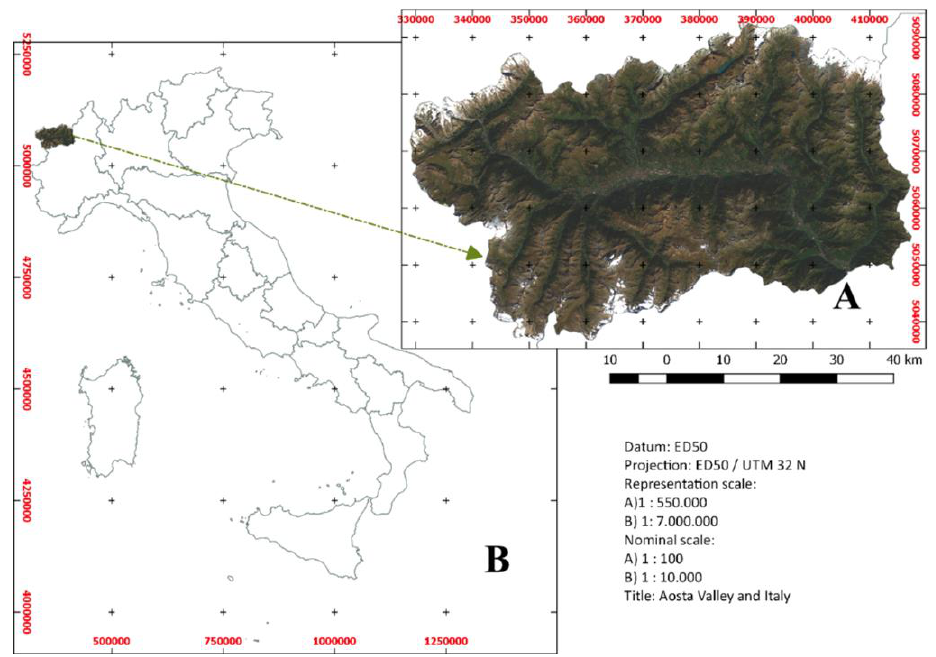
Figure 2. The study area corresponds to the entire Aosta Valley that is located in the Northern West Alps of Italy, close to the border with France and Switzerland.